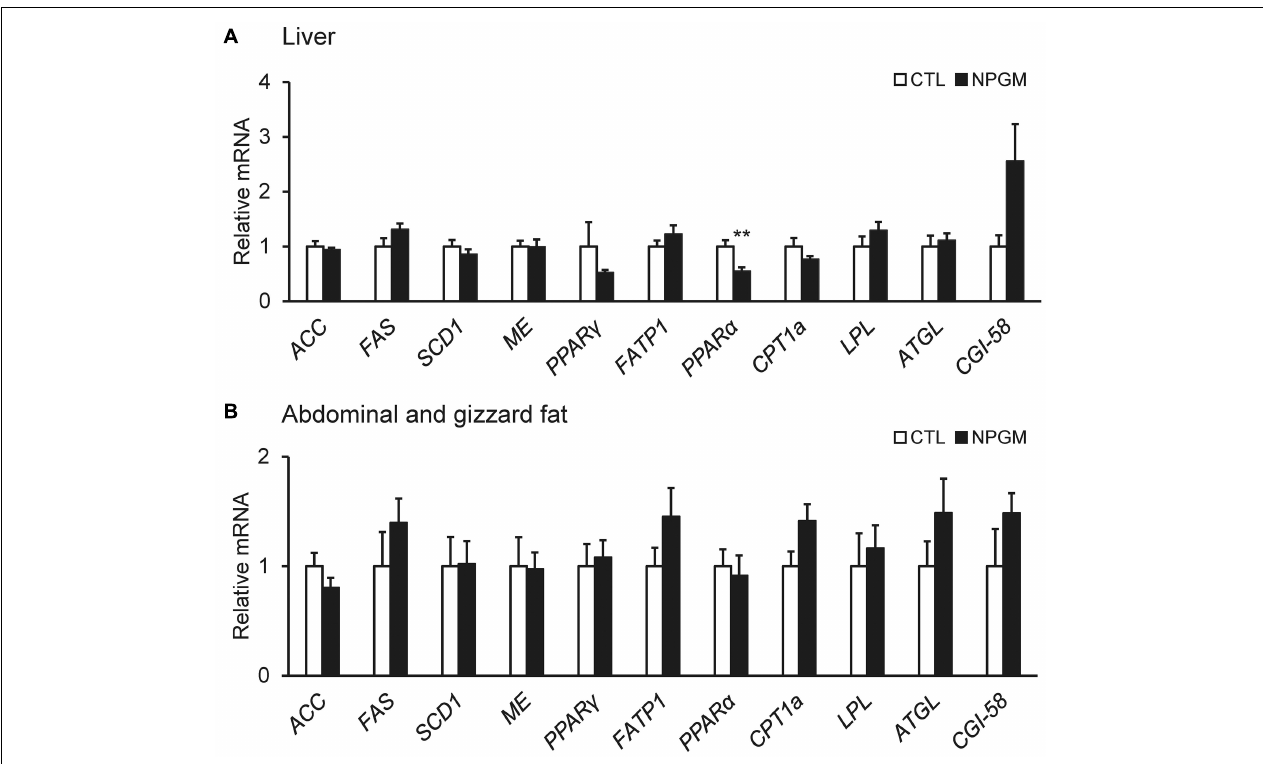
FIGURE 4 | Effect of chronic i.c.v. infusion of NPGM on the mRNA expression of lipogenic and lipolytic factors [acetyl-CoA carboxylase ( ACC ), fatty acid synthase ( FAS ), stearoyl-CoA desaturase 1 ( SCD1 ), malic enzyme ( ME ), peroxisome proliferator-activated receptor γ ( PPAR γ ), fatty acid transporter 1 ( FATP1 ), peroxisome proliferator-activated receptor α ( PPAR α ), carnitine palmitoyltransferase 1a ( CPT1a ), lipoprotein lipase ( LPL ), adipose triglyceride lipase ( ATGL ), and comparative gene identification-58 ( CGI-58 )] in the liver (A) and the abdominal and gizzard fat (B) . The results were obtained 2 weeks after infusion of the vehicle (control; CTL) and NPGM. Data are expressed as the mean ± SEM ( n = 7–8). Data were analyzed by Student’s t -test. An asterisk indicates a statistically significant difference (** P <